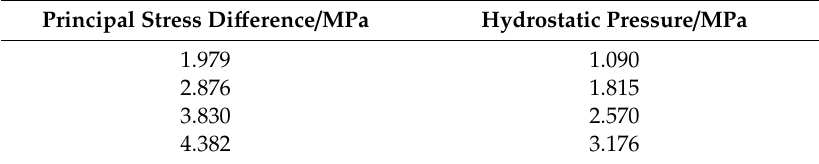
Table 7. Normalized principal stress di ff erence σ ∗ and hydrostatic pressure P ∗